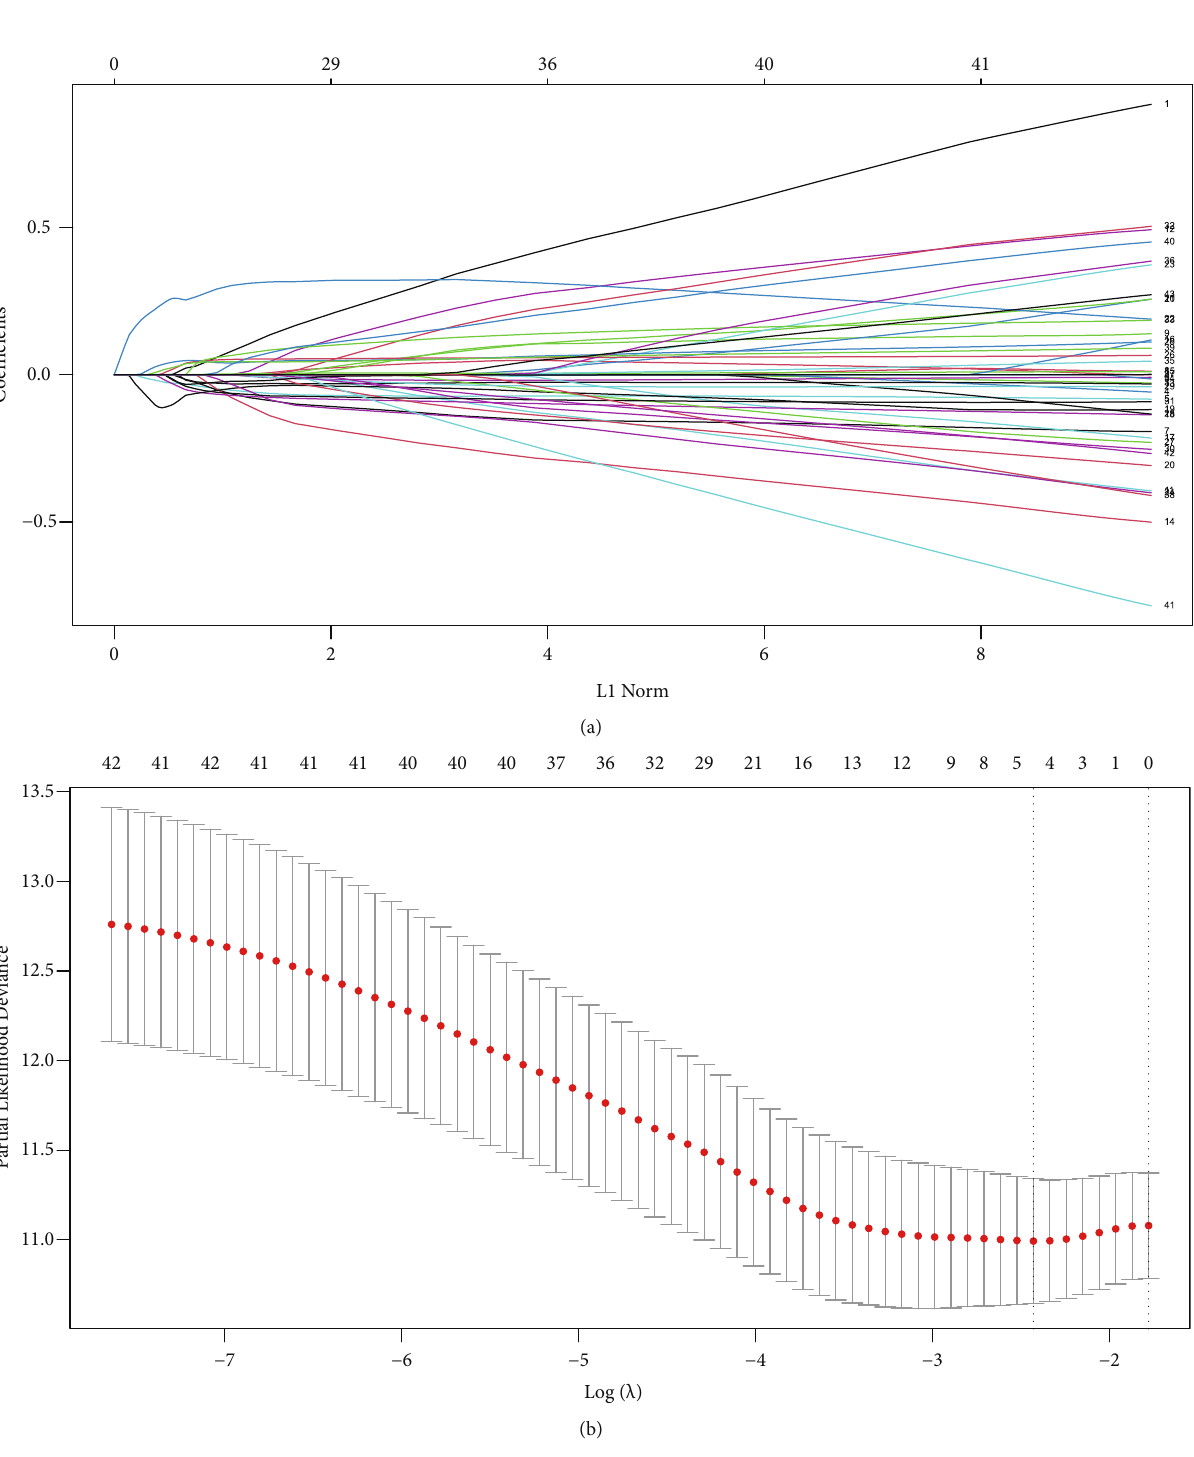
Figure 3: Risk score prognostic signature construction using LASSO Cox penalized regression analysis along with 10-fold cross validation. (a) LASSO coe ffi cient pro fi les of the LLPS genes associated with the OS of HCC patients. (b) Partial likelihood deviance plotted versus log(lambda). The vertical dotted line indicates the lambda value with the minimum error and the largest lambda value where the deviance is within one standard error (SE) of the